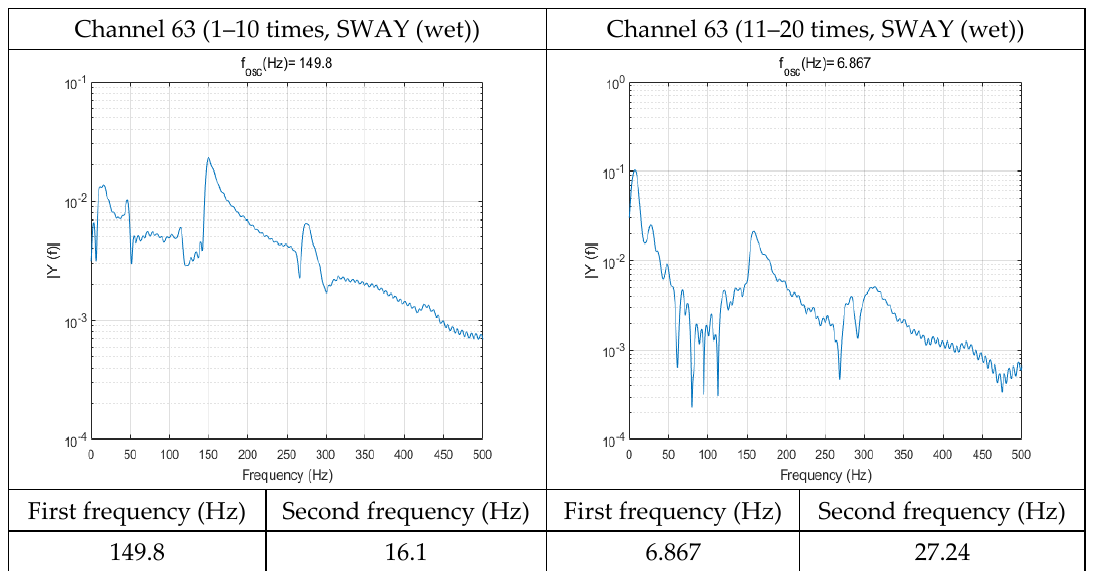
Figure 20. FFT of Channel 58 (Wet Condition, SWAY). J. Mar. Sci. Eng. 2019 , 7 , x FOR PEER REVIEW